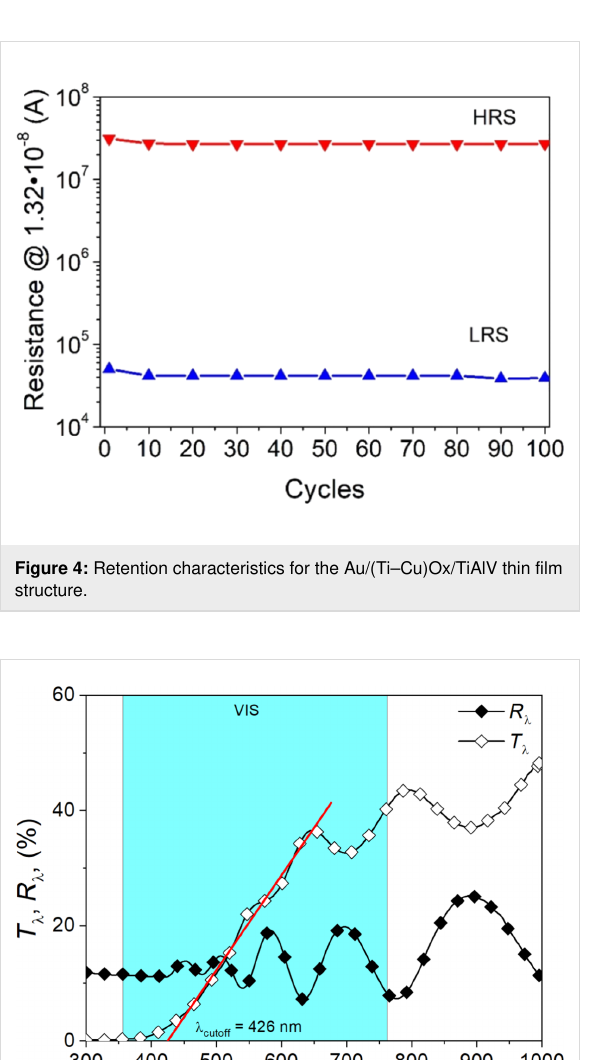
Figure 3: Switching characteristics for the Au/(Ti–Cu)Ox/Ti6Al4V thin film structure as a function of the forcing current for both directions of the current flow.